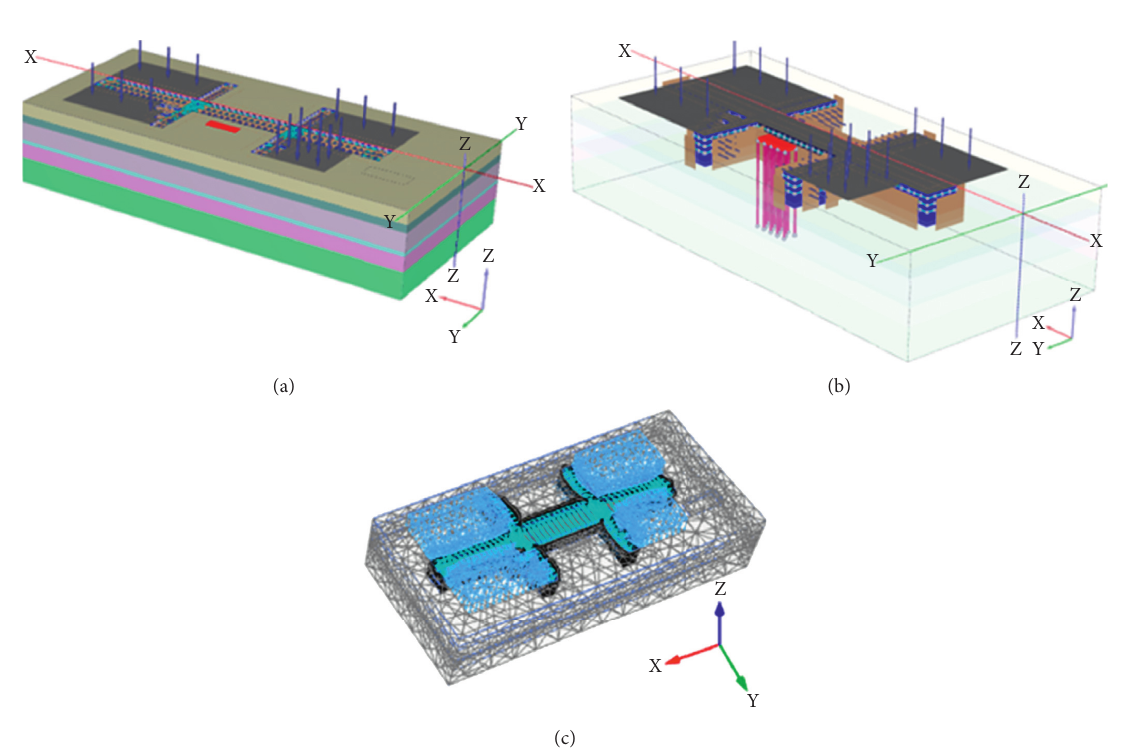
Figure 5: PLAXIS 3D numerical model overview. (a) Model. (b) Structure. (c) Mesh